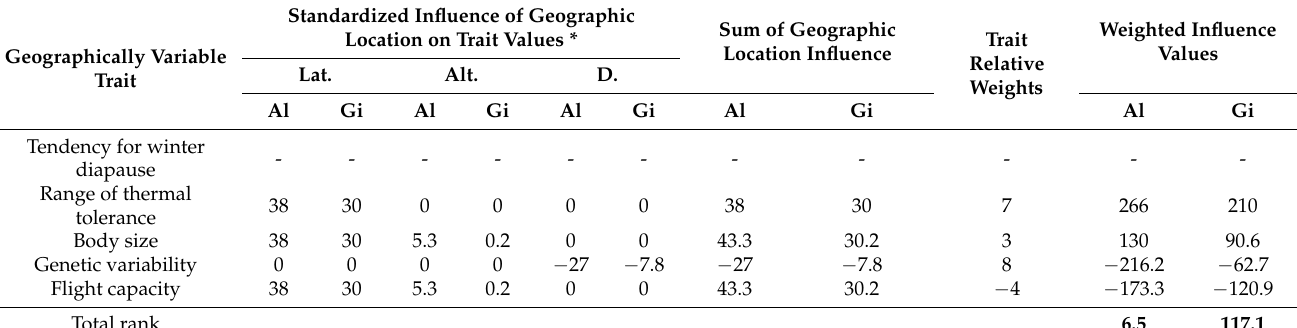
Table 3. Evaluation of the relative suitability of Orius albidipennis collected in Albacete, Spain and in Giza, Egypt for an inoculative biological control program in a temperate region (based on the quantitative method presented in Table 1).